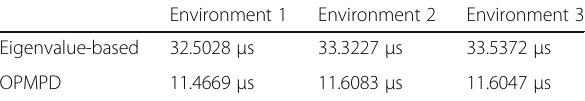
Table 3 Average running time comparison of OPMPD approach and eigenvalue-based approach towards TOA-based localization